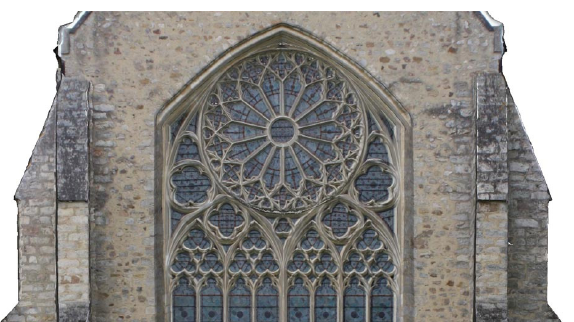
Figure 8. Textured mesh over the rosette of the abbey-church using the refined mesh and the texture image from Figure 7.